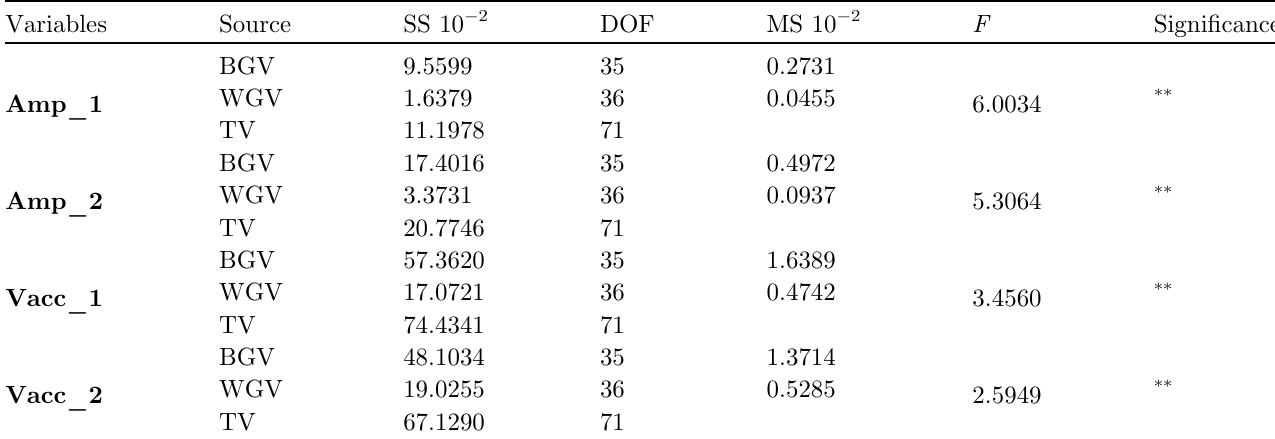
Table 6. Signi fi cance test result of the measured data.